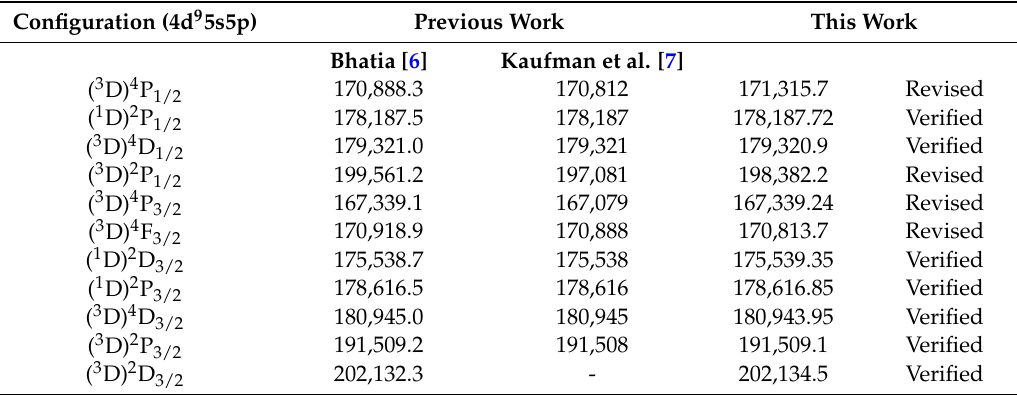
Table 4. Energy level values ( J = 1/2 & 3/2 Levels) of 4d 9 5s5p